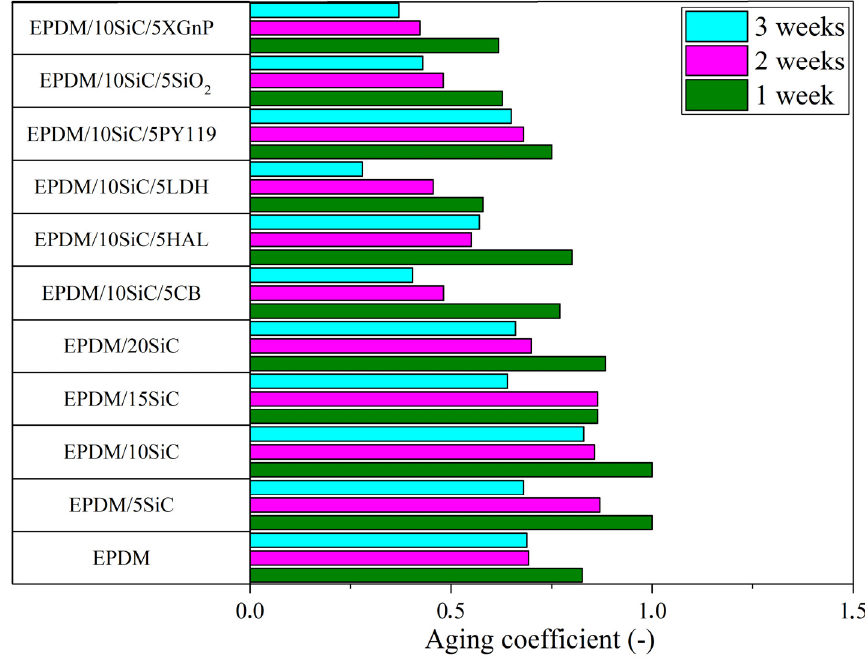
Figure 6. Aging coefficient calculated for composites before and after thermo-oxidative ageing.